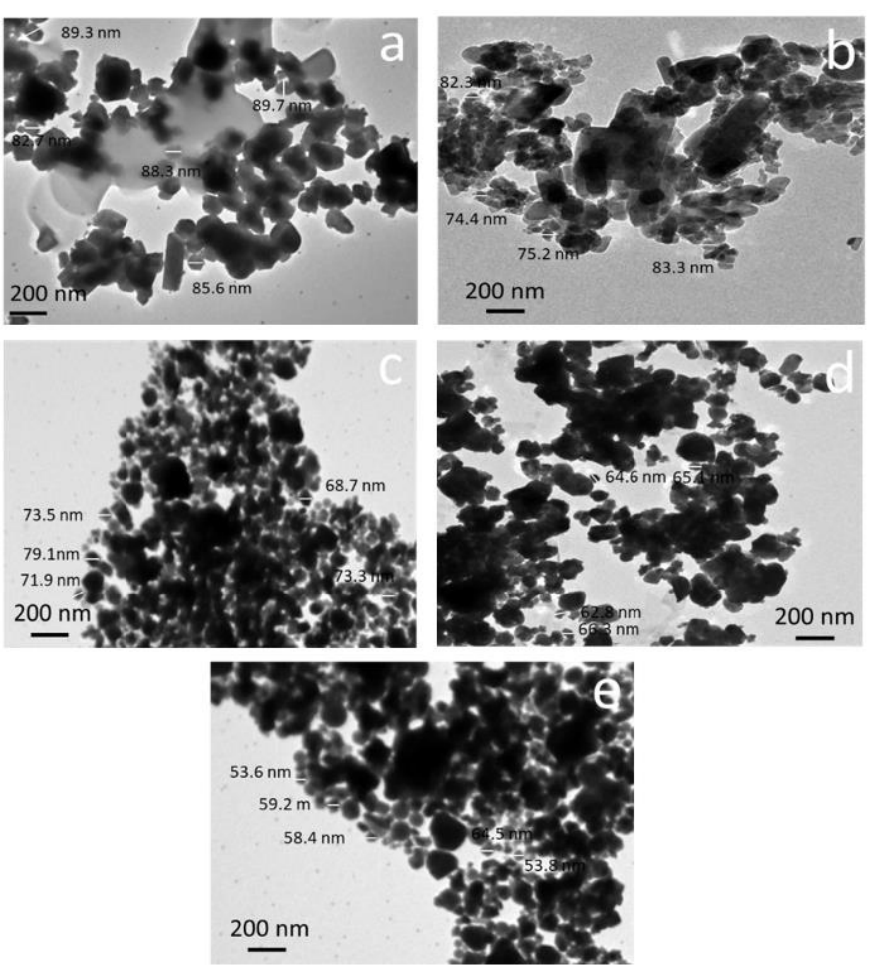
Figure 4. TEM images of ( a ) FGC-0, ( b ) FGC-1, ( c ) FGC-2, ( d ) FGC-3, and ( e ) FGC-4 powders after 20 h of milling.